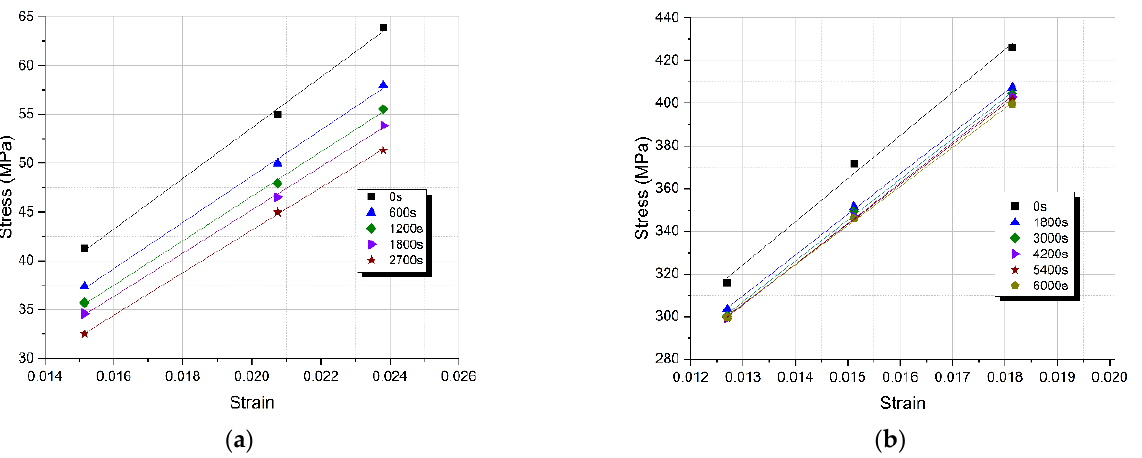
Figure 10. Isochronous curves ( a ) of the neat epoxy resin and ( b ) the GFRP composite at different times.